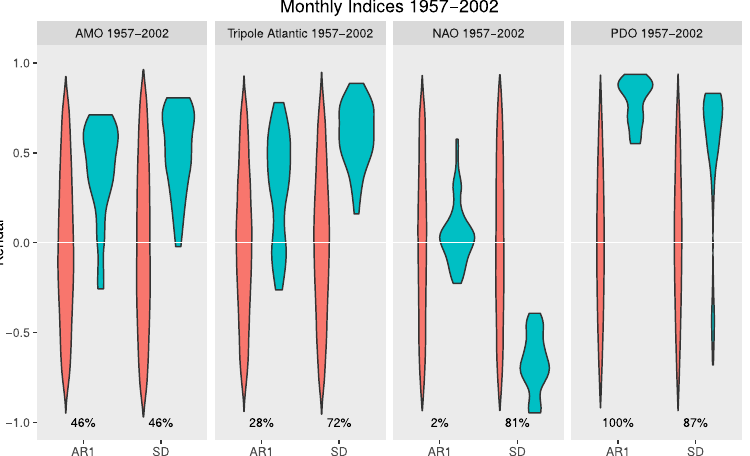
Figure 1. Autocorrelation and variance trends in climate indices. For the ERA-40 interval (09/1957-08/2002). Distribution of Kendall τ trends in AR(1) and standard deviation for all combinations of sliding window and bandwidth size in observational climate indices (blue-green) and null models (red; from 1000 time-series with same frequency spectrum) (see Methods sections Sensitivity analysis, Significance testing). The percentages represent the fraction of results from the observational indices that are significantly different to the null models ( p = 0.1 two